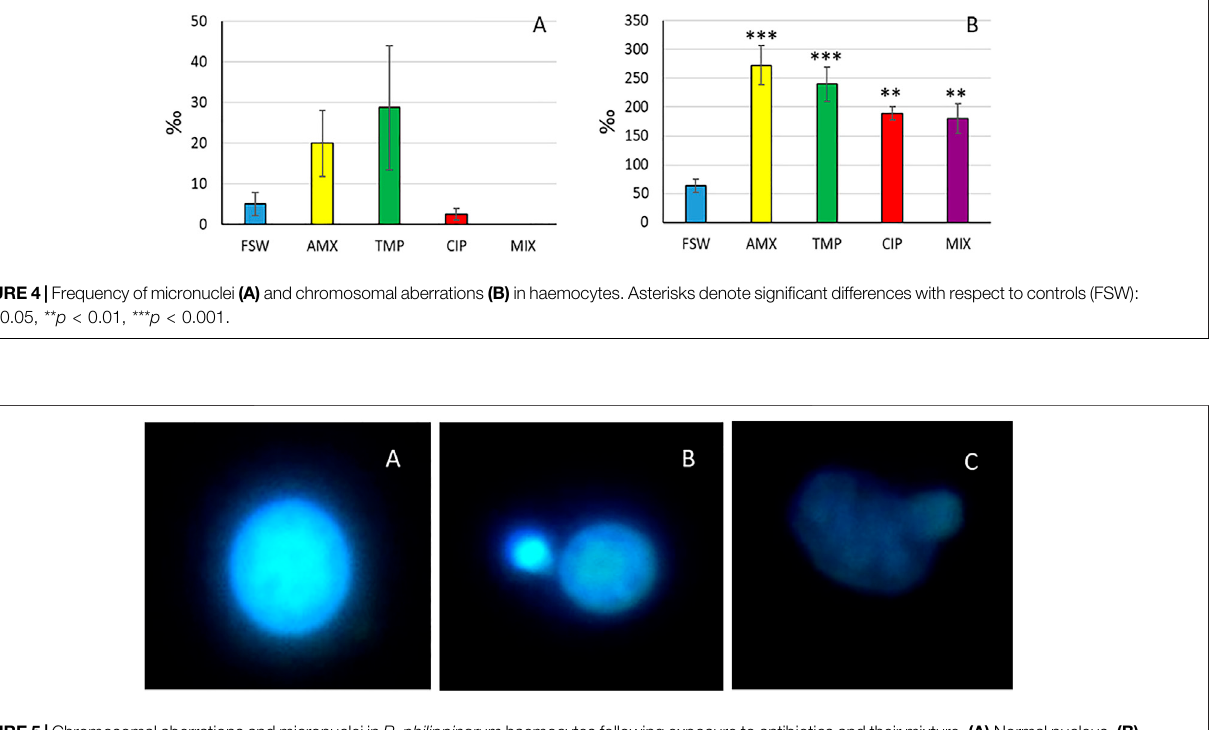
Frontiers in Environmental Science |